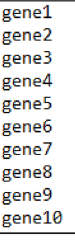
Figure 2. Example input